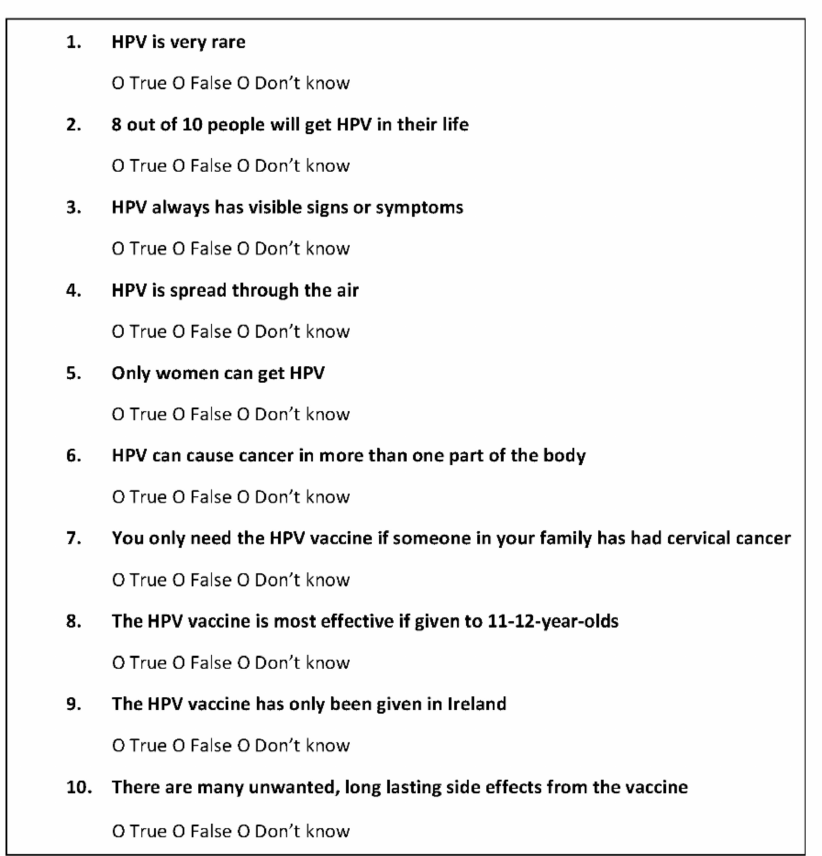
Figure 1. HPV and HPV vaccine knowledge